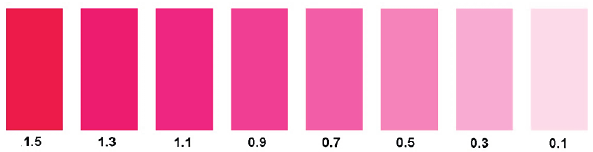
Fig. 2. Scale for reading colour of the occlusal contact intensity